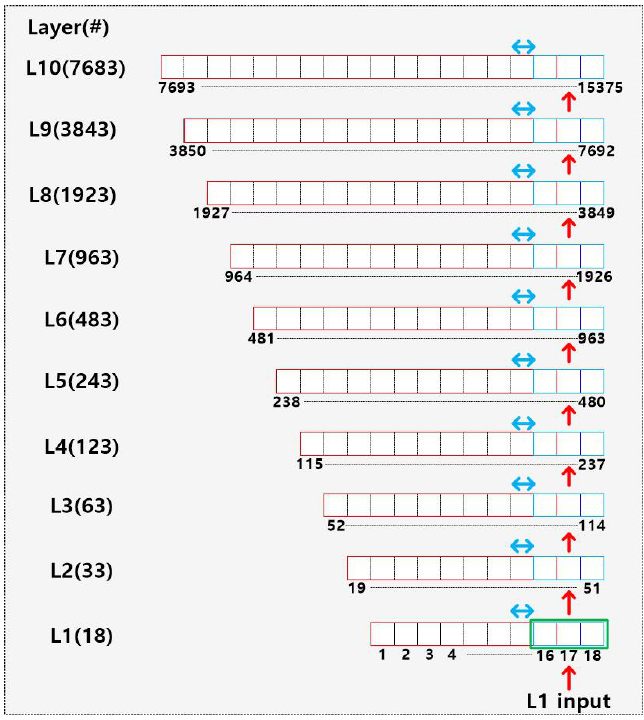
Figure 11. Dilated buffer address used for the dilated 1-D convolution.